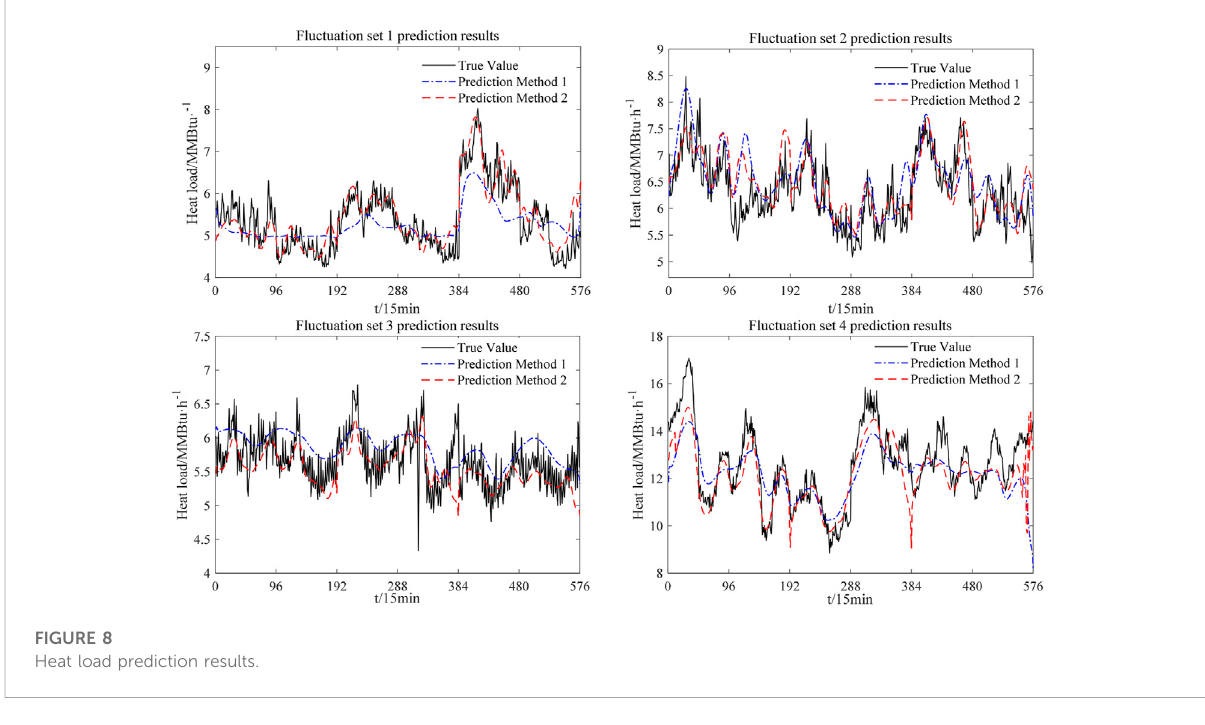
FIGURE 8 Heat load prediction results.